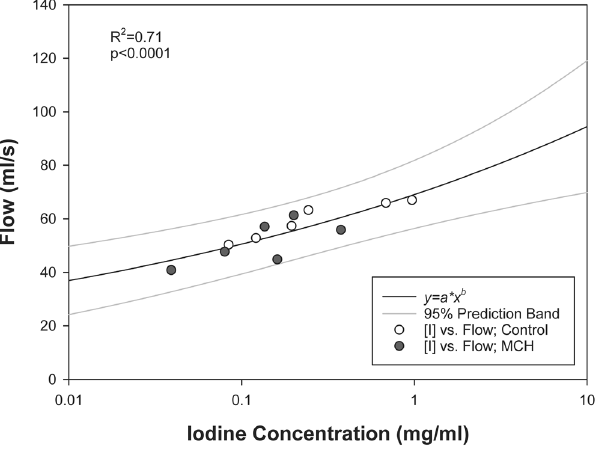
Figure 8. Relation between mean inspiratory air flow during inhalation and mean iodine concentration within the imaged lung. Black line : Fitted power function; Grey lines : prediction limits.